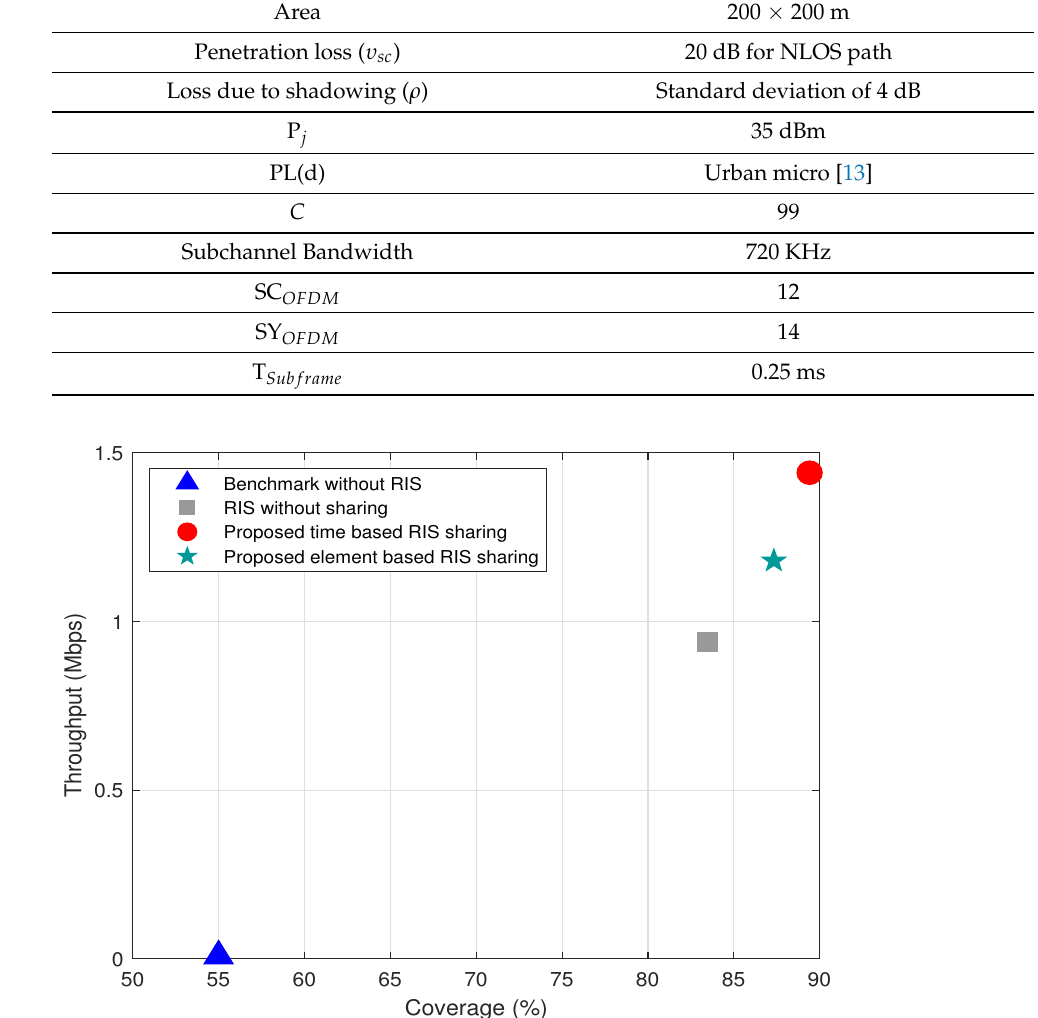
Figure 5. Variation of throughput with respect to coverage for µ u = 40, µ pu = 40%, N = 40, µ b = 2, and α =